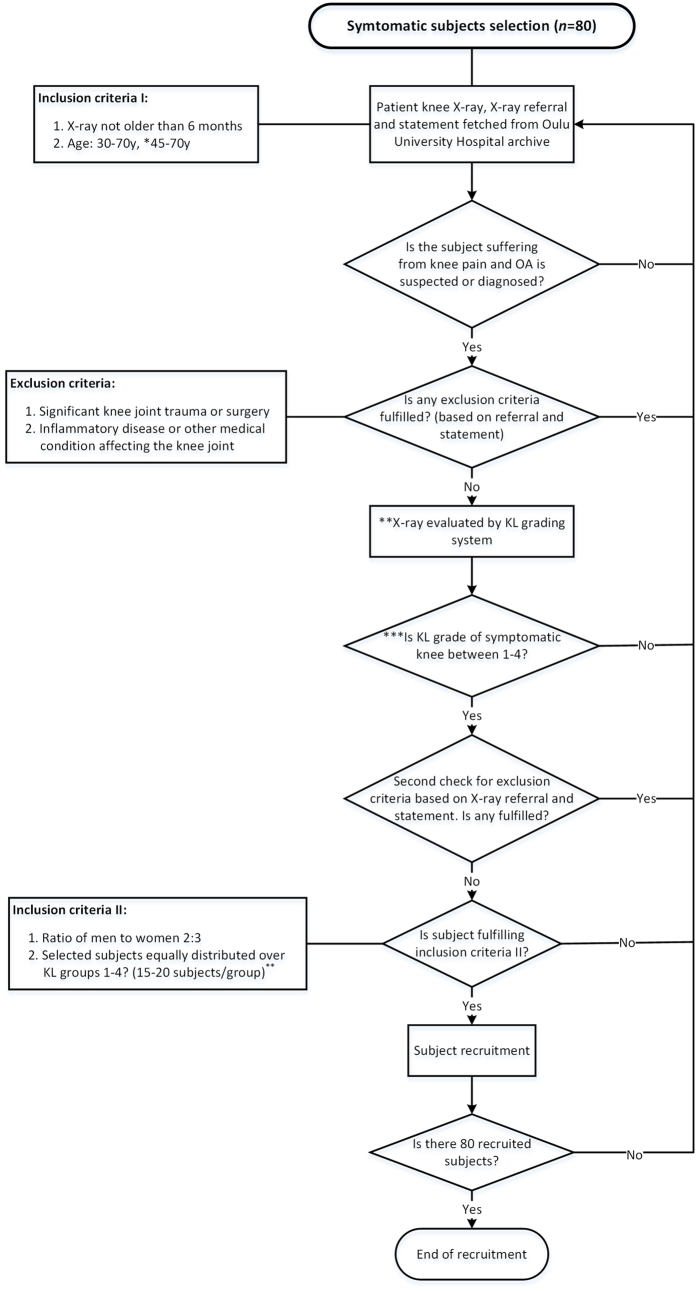
Flowchart describing the selection of symptomatic subjects.*After pilot examinations of 21 subjects the age range was modified to easier recognize the OA subjects (as OA prevalence increases with age). **X-rays were evaluated by a rheumatologist with 25 years of experience in reading knee X-rays. ***Except of subjects with KL 0 included in pilot examinations.